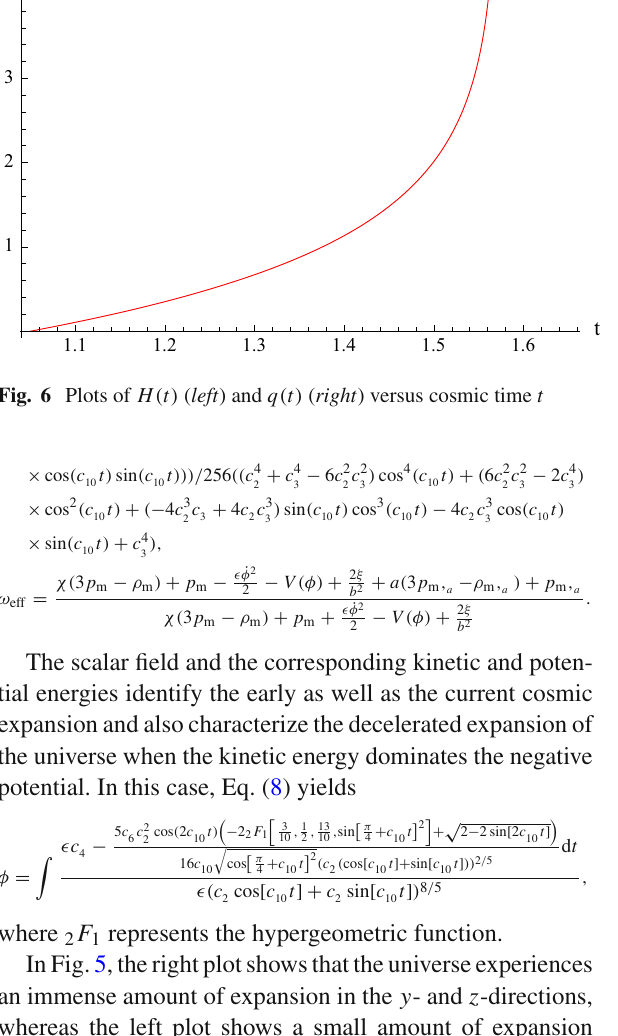
Fig. 6 Plots of H ( t ) ( left ) and q ( t ) ( right ) versus cosmic time t